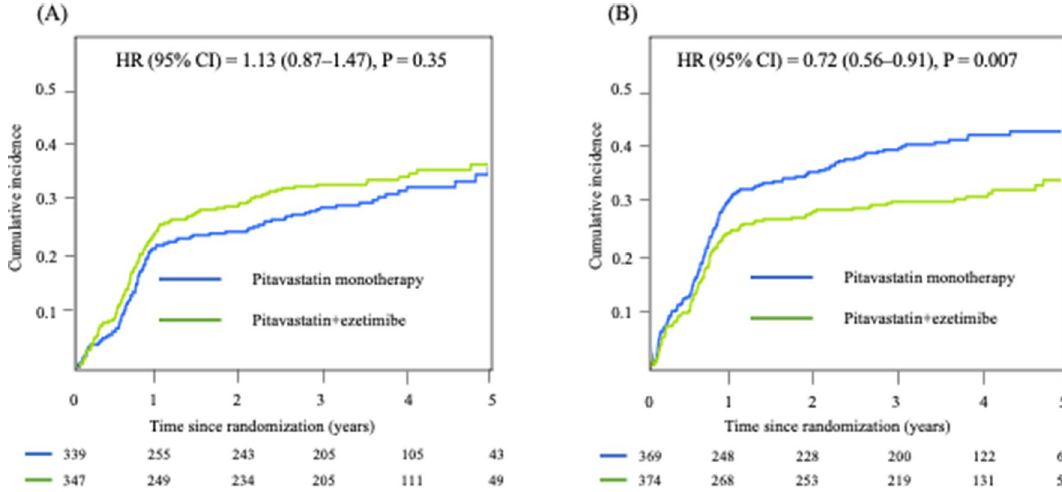
Figure 3. Primary outcome in the LDL-C < 131 mg/dL group ( A ) and the LDL-C < 131 mg/dL group ( B ). LDL- C, low-density lipoprotein cholesterol; HR, hazard ratio; CI, confidence interval.